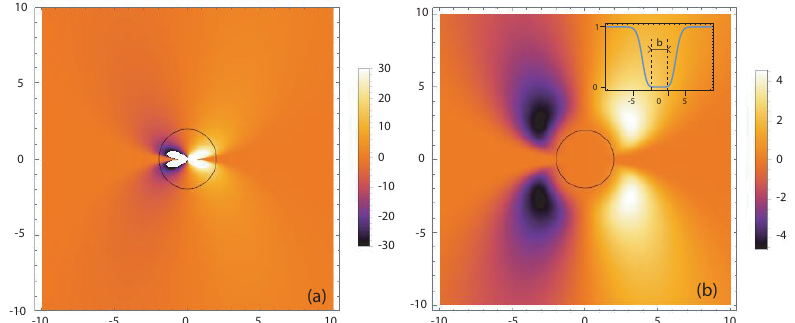
Figure 5. Density plot of the elastic potential. ( a ) raw potential. It strongly diverges inside the white regions; ( b ) smoothed potential W ( x , z ) ≡ W ( x , z ) f c ( r ) . The function f c ( r ) is shown in the inset. The two circles represent the core of the dislocation. The lengths are given in units of λ and the potentials in units of k B T (from Ref. [28], with kind permission of the European Physical Journal).